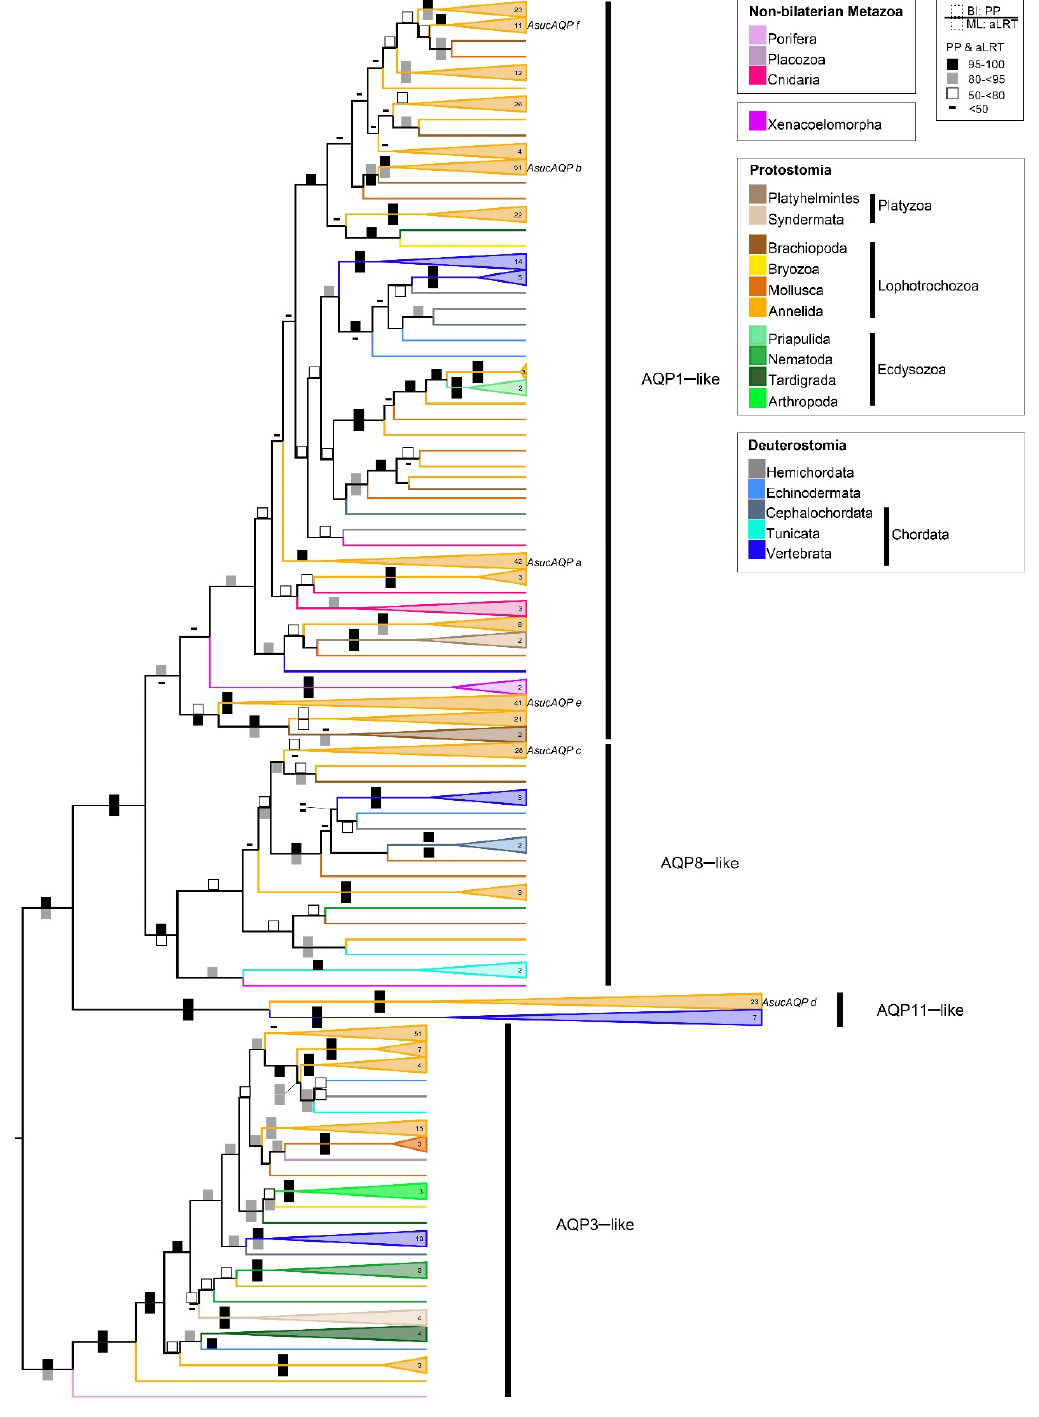
Figure 2. Phylogenetic reconstruction of metazoan Aqps . Bayesian tree obtained from 518 sequences, 418 amino acid sites, re-rooted with AQP3-like group. Squares on branches represent the support values for Bayesian inference (BI posterior probabilities; upper square) and maximum likelihood (ML aLRT; lower square) reported as percentages (nodes not recovered in the ML are without symbols). Branches are coloured according to taxonomy. Labels in the tree refer to the annelid Alitta succinea Aqps ( AsucAQPa, b, c, d, e, f) described in Table 1. The fully annotated and midpoint-rooted trees, the alignment and analyzed sequences are available in the Supplementary Materials (Figures S1 and S2; Data S1; Table S1).